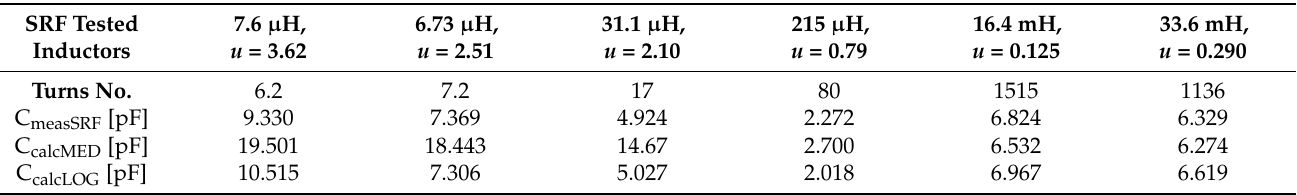
Table 2. Tesla coils and RF cable inductors measured self-capacitance compared to the calculated Medhurst and our logarithmic